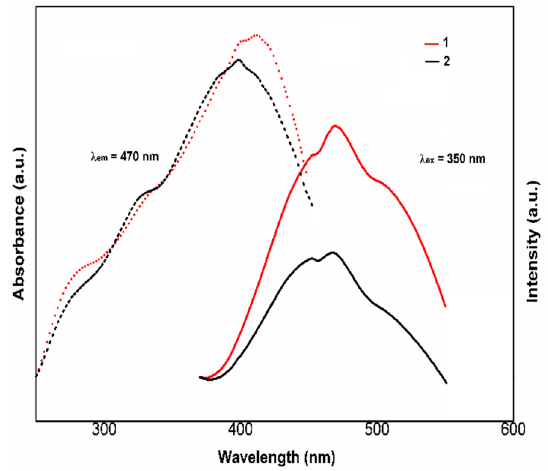
Figure 5. The solid-state emission ( right ) and excitation ( left ) spectra for the compounds 1 and 2 .